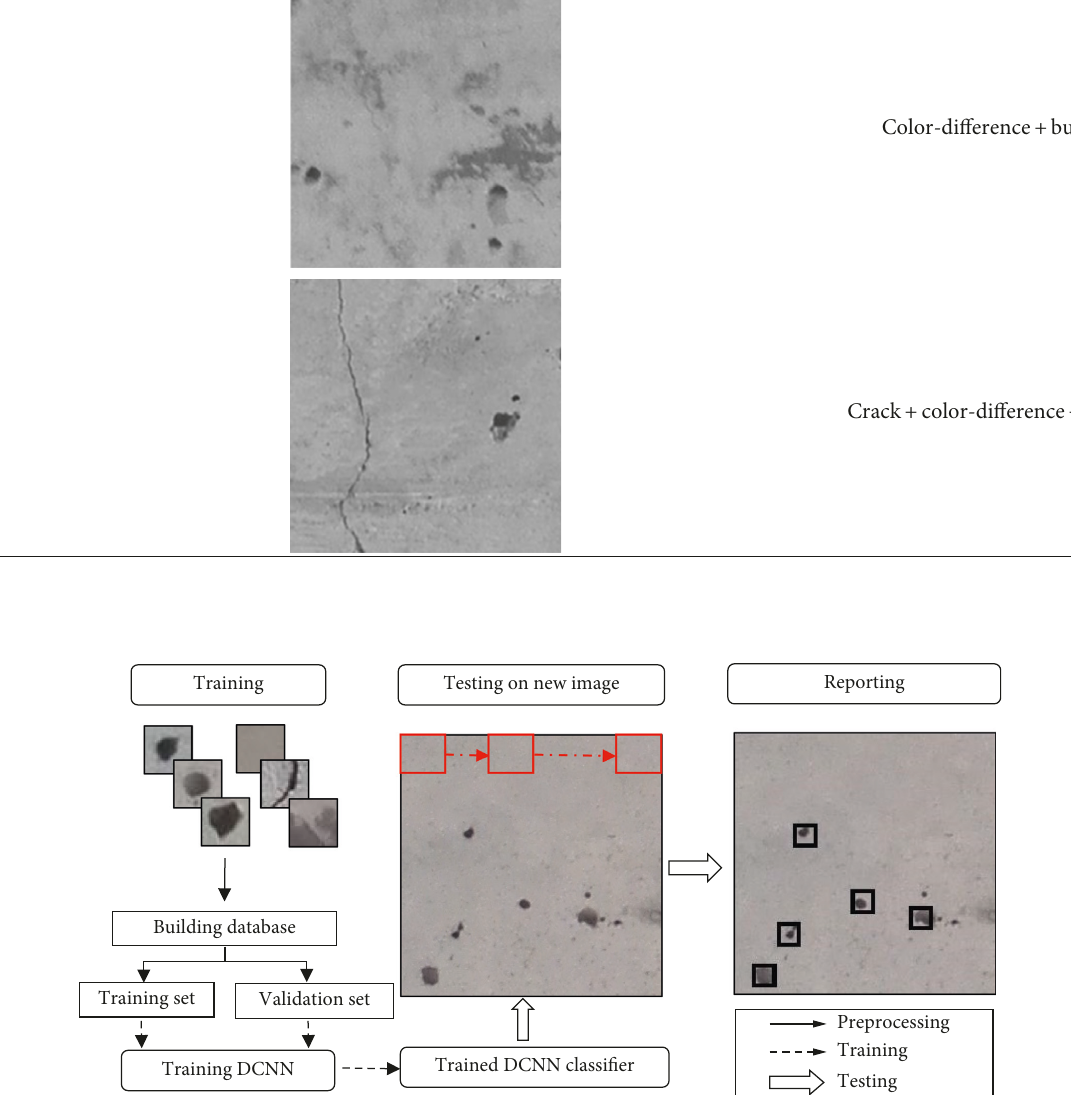
Figure 4: Flowchart for detecting concrete surface